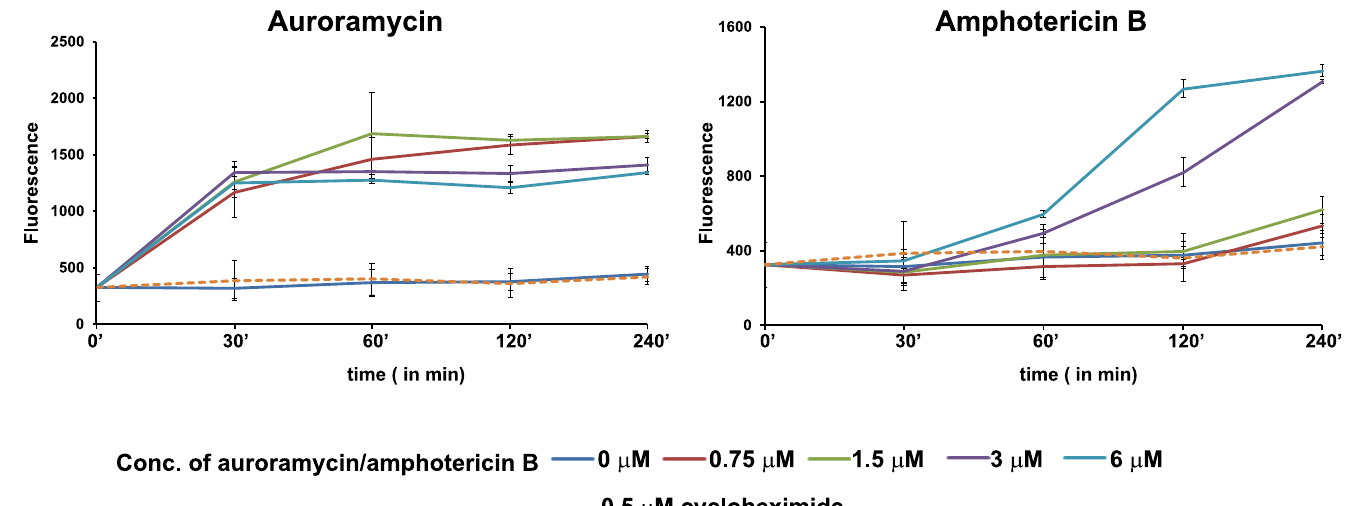
Fig 8. Auroramycin disrupts the membrane permeability of yeast cells. Fluorescence reading (emission at 525 nm, excitation at 495 nm) in the supernatants of CFDA-labelled wild type yeast cells at different time points, after treatment with DMSO, cycloheximide or various concentrations of auroramycin or amphotericin B in triplicates. Error bars (n = 3 Mean ± S.D) represent standard deviation. Representative data from two independent experiments are shown.